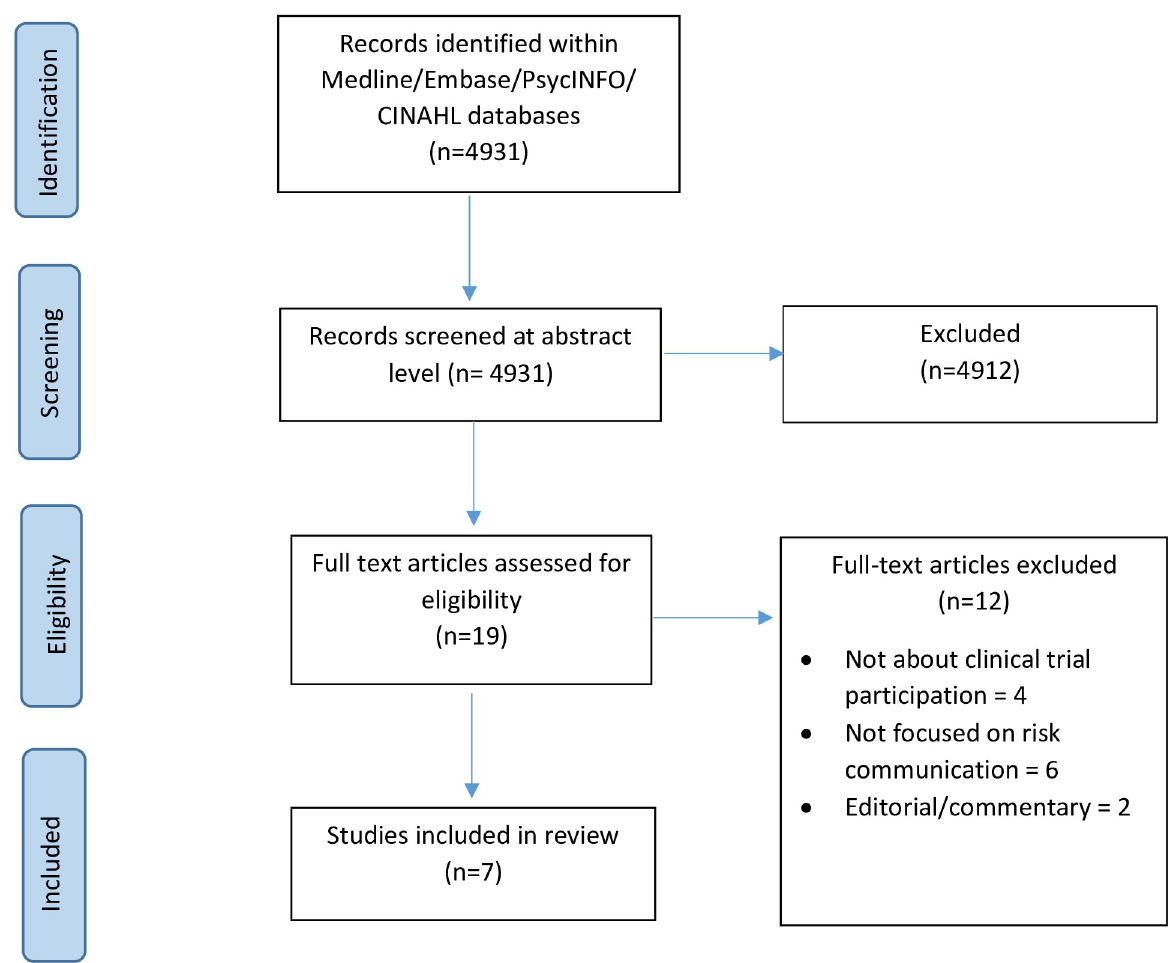
Fig 1. The PRIMSA diagram details our search and selection process applied during the literature review.